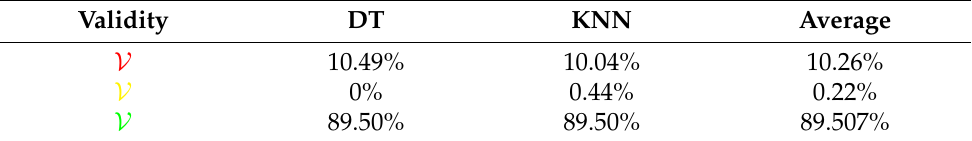
Table A3. Rate of validity of RHOASo vs. HPO across all D i (% with MCC and time complexity).